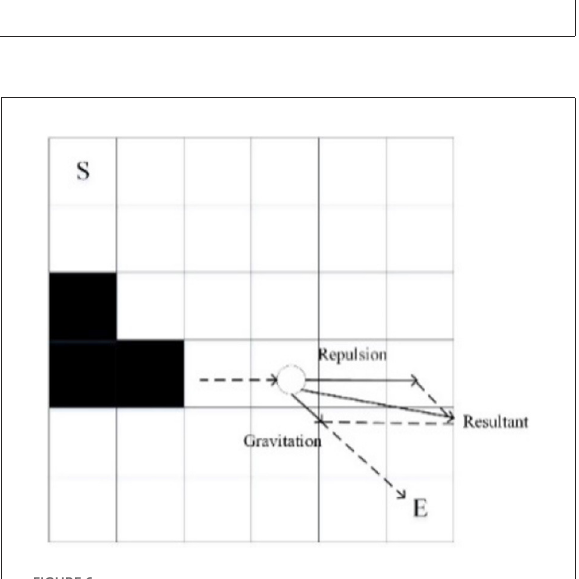
FIGURE6 Artificial potential field